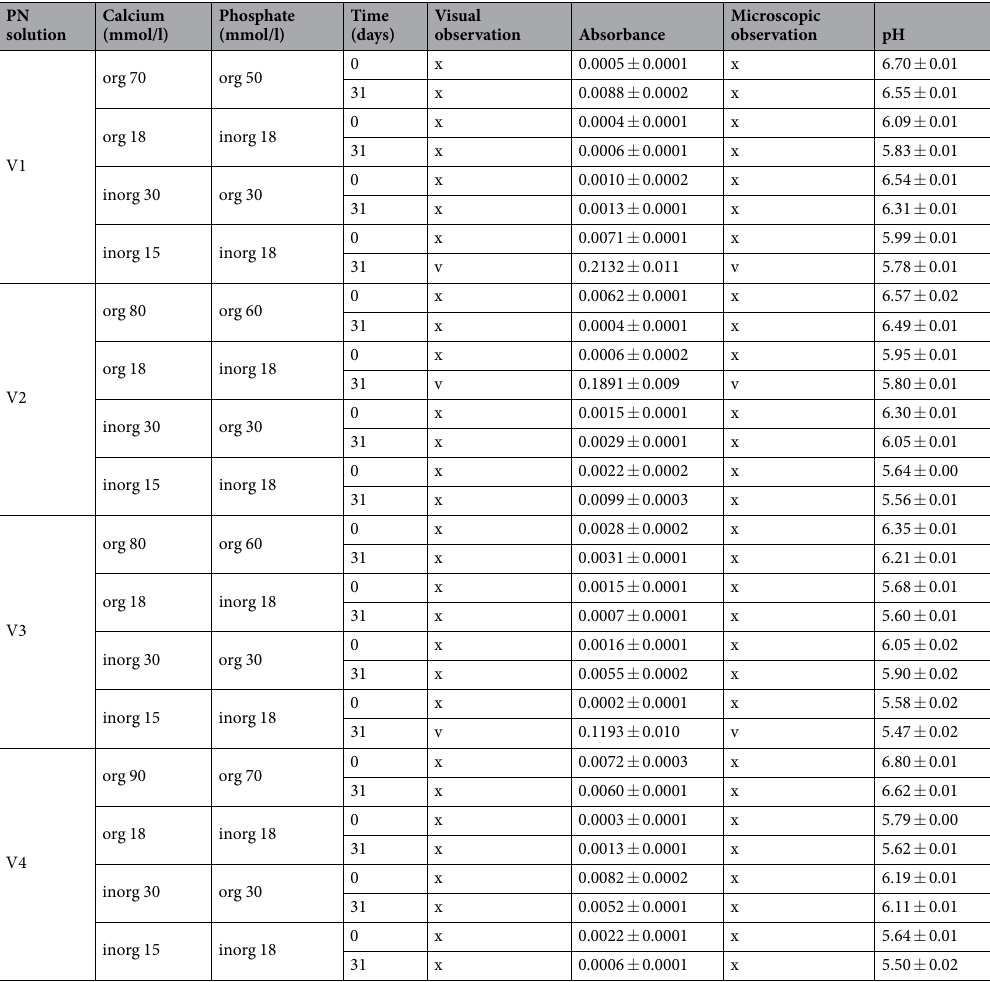
Table 3. Physicochemical Properties of PN Solution Composition V (n = 9; mean ± SD). x = no precipitation. v = precipitation.